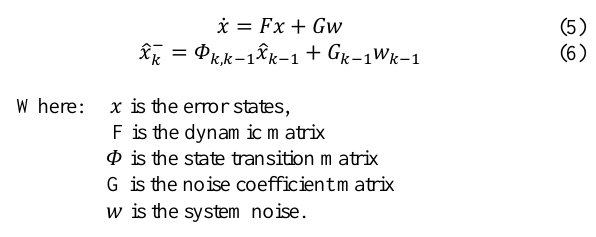
Figure 1. The work scheme of the proposed integration between camera and UWB system through Extended Kalman Filter loosely coupled scheme.